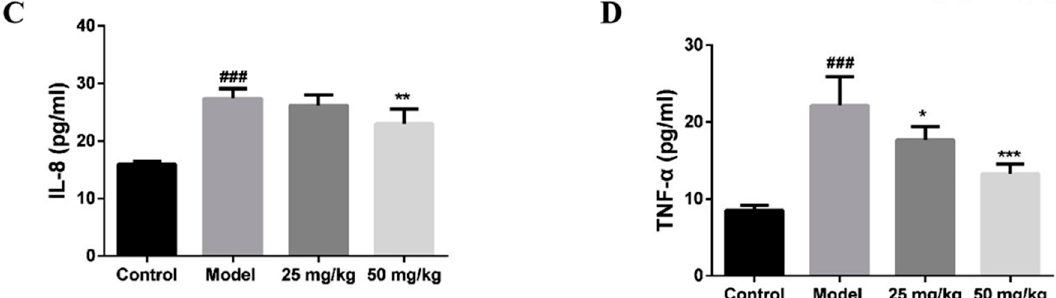
Figure 7. Effect of AT on C48/80-induced active systemic anaphylaxis. ( A ). A 30-min treatment of AT restored the hypothermia caused by C48/80 (0.3 mg/kg), recorded in 30 min. ( B – D ). The effect of 30-min pretreatment of AT on the serum concentrations of histamine, TNF- α , and IL-8 after injection with C48/80 (0.3 mg/kg). The data are presented as the mean ± S.D. * p < 0.05, ** p < 0.01, *** p < 0.001 versus the model group. ### p < 0.001 versus the control group, n = 6.